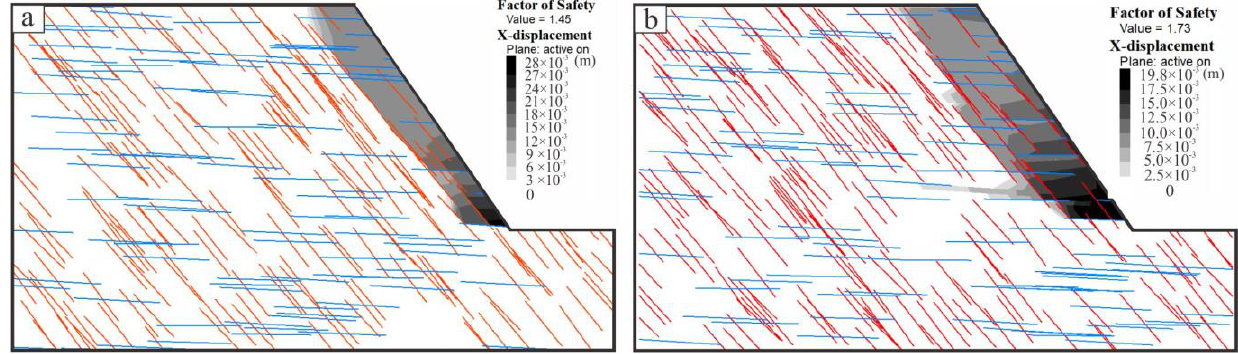
Figure 4. Horizontal displacement contours for an identical slope with two distinct fracture arrange- ments (a-a realization of DFN with Fs =1.45; b-another realization of DFN with Fs =1.73).